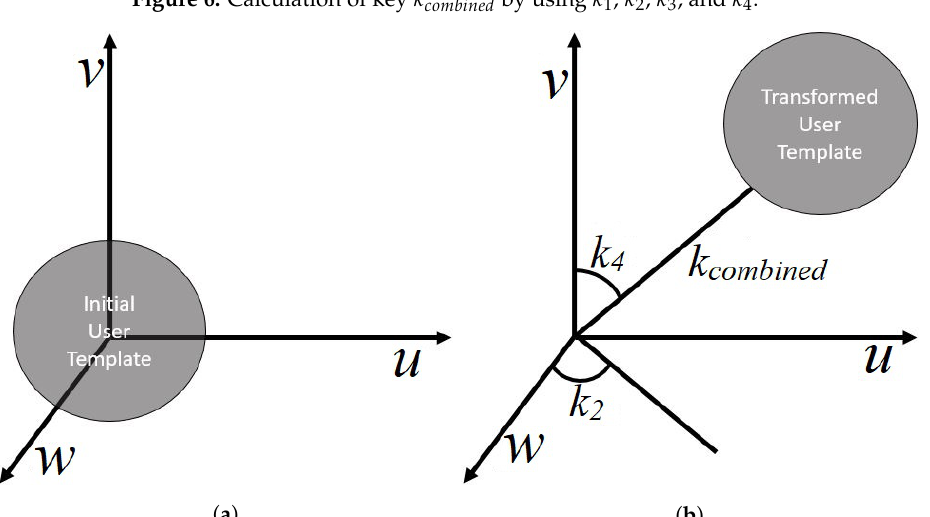
Figure 7. Security enhancement ( a ) Initial template, ( b ) Final template after transformation using the keys k 2 , k 4 , and k combined .